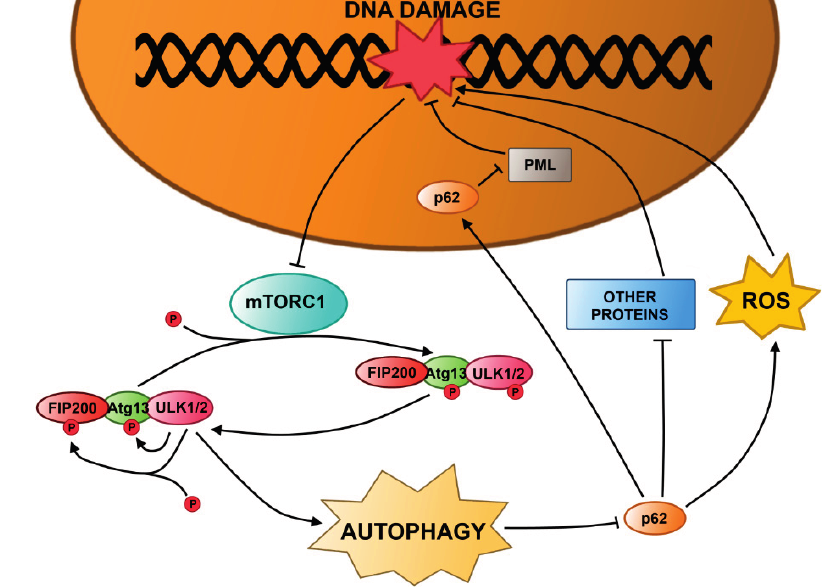
Figure 3. FIP200 (FAK (focal adhesion kinase)-family interacting protein of 200